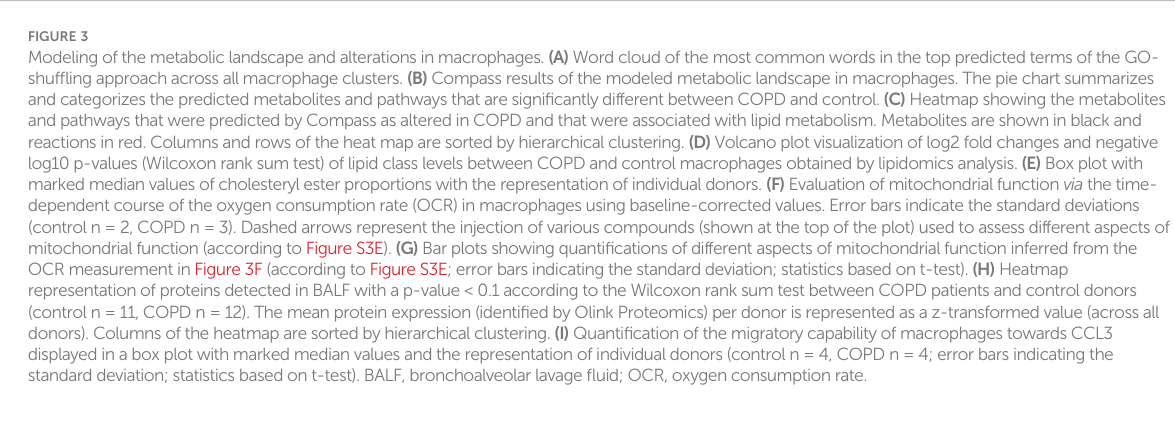
FIGURE 3 Modelingof themetaboliclandscape andalterations inmacrophages. (A) Wordcloudof themostcommonwordsin thetoppredictedtermsofthe GO- shuf fl ingapproachacrossallmacrophageclusters. (B) Compassresultsofthe modeledmetaboliclandscape in macrophages. Thepie chartsummarizes and categorizesthe predictedmetabolitesandpathwaysthataresigni fi cantlydifferentbetweenCOPDandcontrol. (C) Heatmapshowingthemetabolites and pathwaysthatwere predictedby Compass asalteredinCOPDandthatwere associatedwithlipidmetabolism. Metabolitesareshownin blackand reactions inred.Columns androws of theheatmapare sortedbyhierarchical clustering. (D) Volcanoplotvisualizationoflog2 foldchangesandnegative log10p-values(Wilcoxonranksumtest)oflipidclasslevelsbetweenCOPDandcontrol macrophagesobtainedbylipidomicsanalysis. (E) Box plotwith marked medianvaluesof cholesterylesterproportionswiththerepresentationof individual donors. (F) Evaluationof mitochondrialfunction via the time- dependentcourseofthe oxygenconsumptionrate(OCR)inmacrophagesusingbaseline-correctedvalues.Errorbarsindicatethestandarddeviations (control n=2, COPD n=3). Dashedarrows represent theinjectionof variouscompounds (shownatthe topof theplot)usedtoassessdifferentaspects of mitochondrial function(accordingto Figure S3E). (G) Barplotsshowingquanti fi cationsof different aspectsof mitochondrialfunction inferredfromthe OCRmeasurementinFigure3F(accordingtoFigure S3E;errorbarsindicatingthestandarddeviation;statistics basedont-test). (H) Heatmap representationofproteinsdetectedinBALF withap-value<0.1accordingtotheWilcoxonranksumtest betweenCOPDpatientsandcontrol donors (control n=11,COPD n=12). Themeanprotein expression(identi fi edby OlinkProteomics)perdonorisrepresentedasaz-transformedvalue(acrossall donors). Columnsof theheatmaparesortedby hierarchical clustering. (I) Quanti fi cationof themigratorycapabilityofmacrophages towardsCCL3 displayedinaboxplot withmarkedmedianvalues andtherepresentationofindividualdonors(controln=4,COPDn=4;errorbarsindicatingthe standarddeviation;statistics basedont-test). BALF, bronchoalveolarlavage fl uid;OCR,